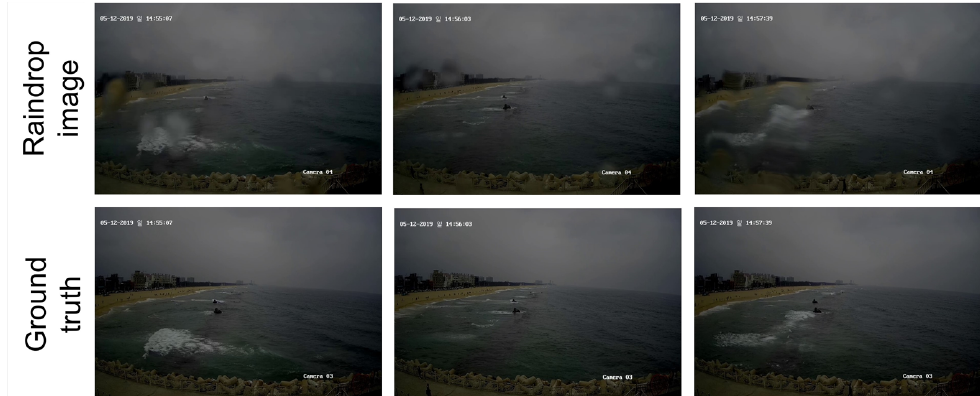
Figure 3. Samples of dataset paired with and without raindrops obtained from Anmok beach. Top : The images contaminated by raindrops. Bottom : The corresponding ground-truth